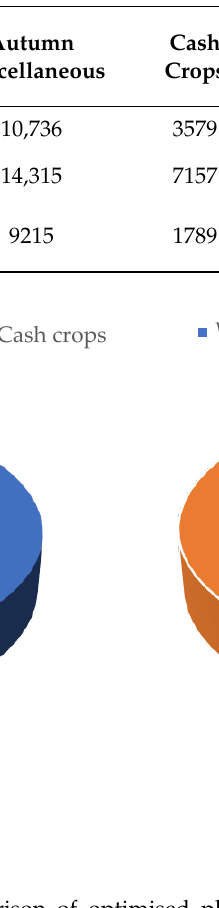
Table 3. Optimisation results of crop planting obtained using different game mechanisms.